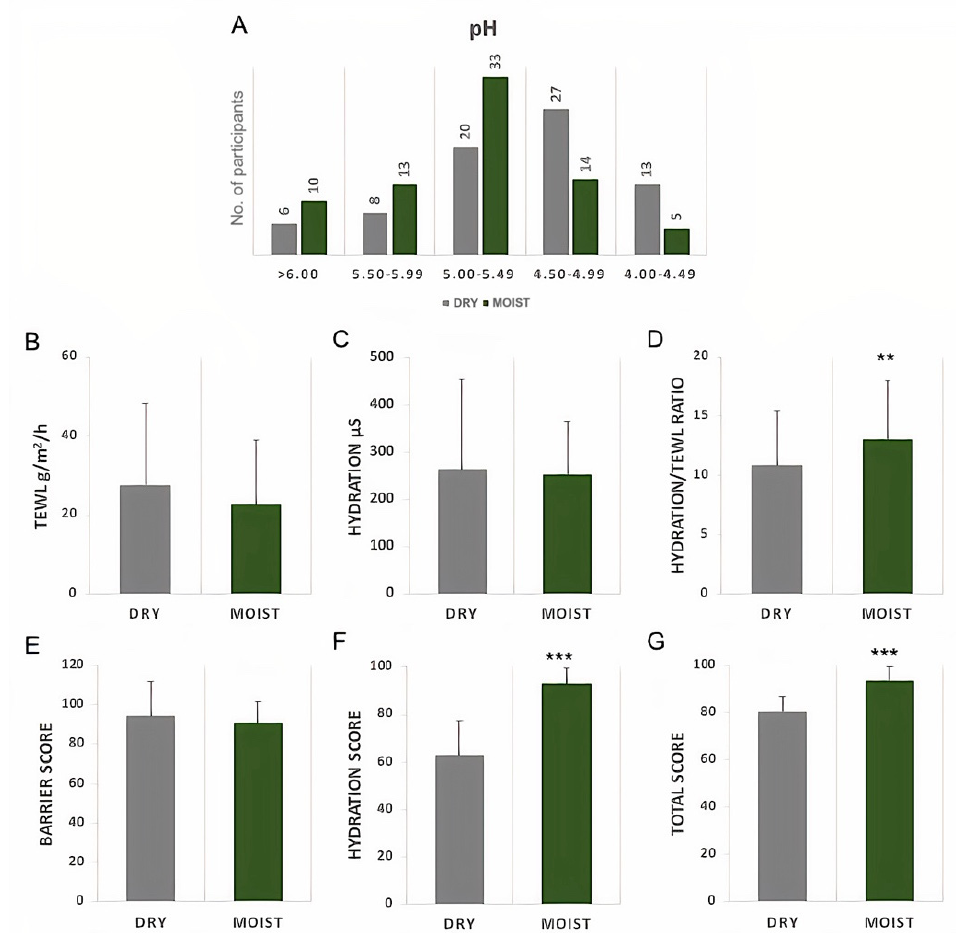
Figure 1. Comparison of skin barrier based on TEWL, hydration and pH. ( A ) pH; ( B ) TEWL (trans- epidermal water loss); ( C ) hydration level; ( D ) hydration/TEWL ratio; ( E ) barrier score; ( F ) hydration score; ( G ) total score. ( A – C ) measurements provided by the Dermalab combo probes. ( E – G ) Provided score from the GPSkin Barrier detector. Data are presented with mean and standard deviation and analyzed with unpaired parametric t-test with Welch correction compared with the dry group. ** p < 0.01, *** p < 0.001.